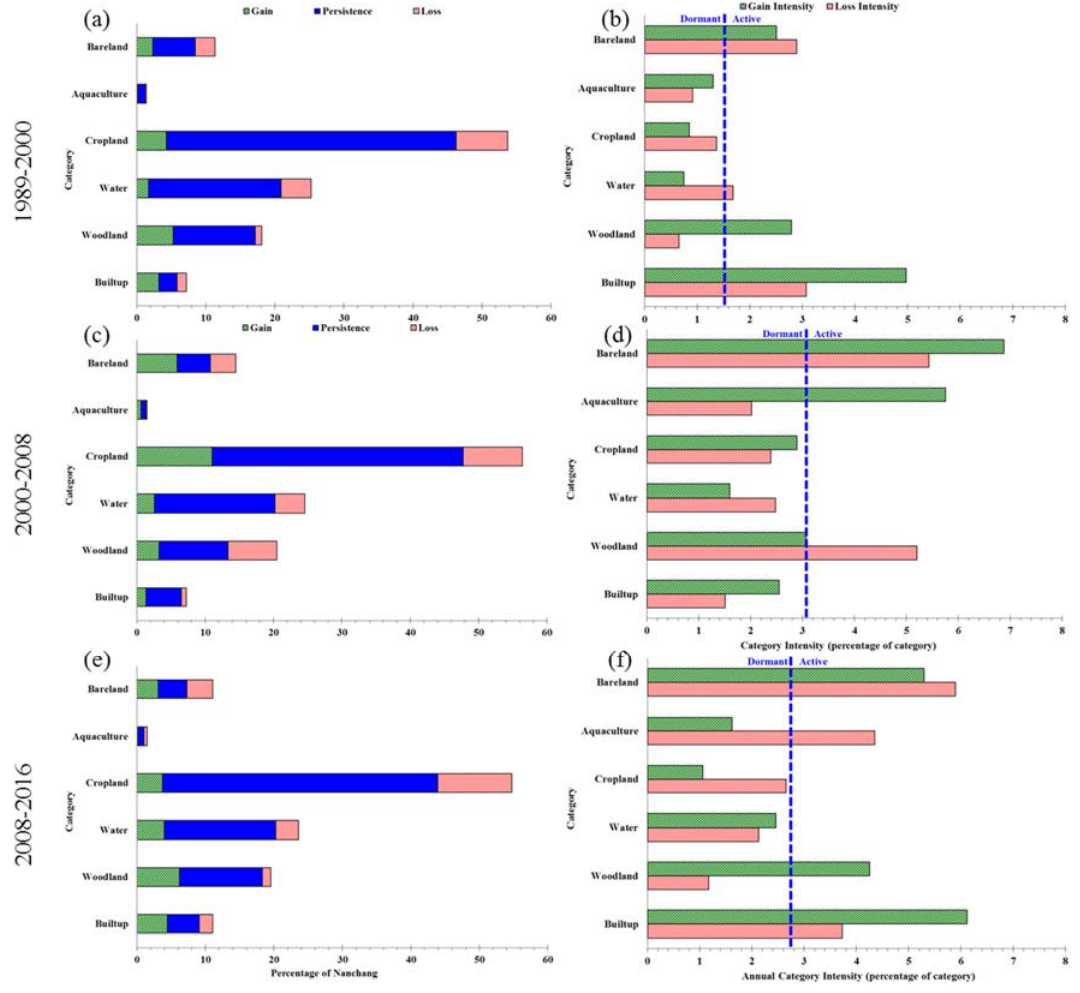
Figure 9. Category level losses and gains for ( a ) ( c ) ( e ) size and ( b ) ( d ) ( f ) intensities. The dashed line indicates the annual difference in overall percentage of Nanchang.